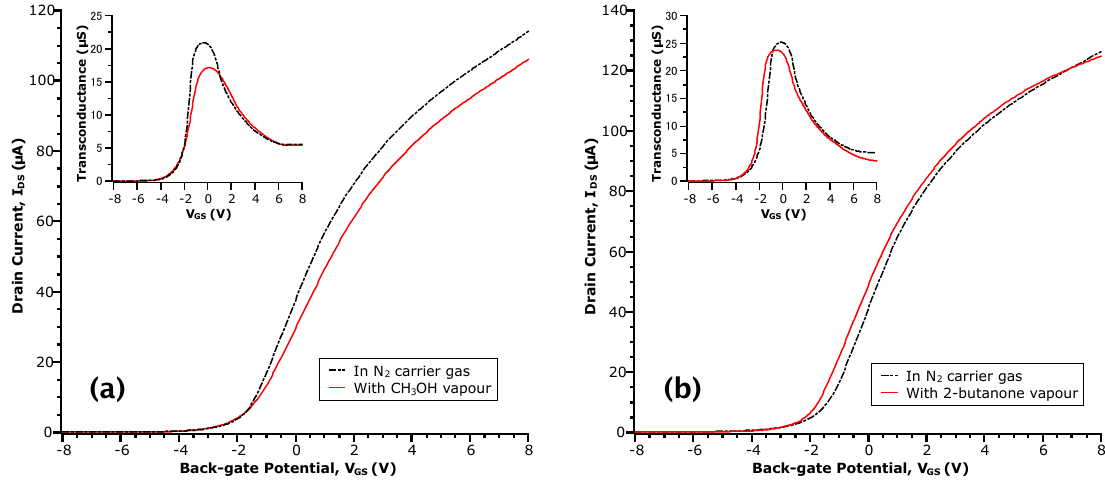
Figure 2. I DS - V GS curves of InAs MWFET in: vapours of ( a ) methanol (CH3OH) at a concentration of P / P v = 0.27; and ( b ) 2-butanone at a concentration of P / P v = 0.16. The transfer curve taken in N to each exposure is shown in the dotted-dashed line. Insets are the respective transconductance curves obtained by numerical differentiation of the